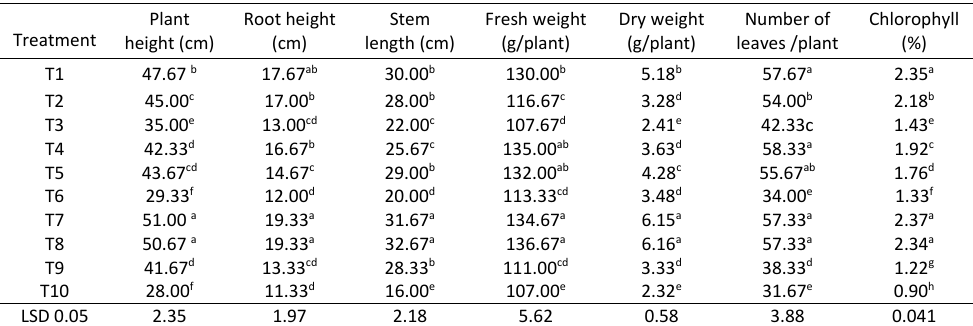
Table (4): Effect of different fertilizers on celery growth Table 4. Effect of different fertilizers on celery Treatment